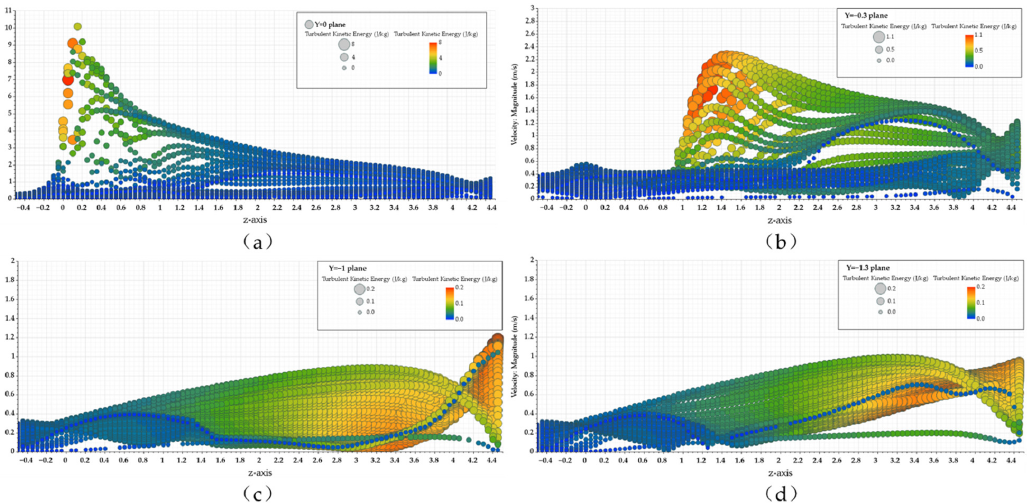
Figure 3. The velocity and turbulent kinetic energy bubble plots of four axial planes along Z-axis direction: ( a ) Y = 0 plane; ( b ) Y = − 0.3 plane; ( c ) Y = − 1 plane; ( d ) Y = − 1.3 plane.